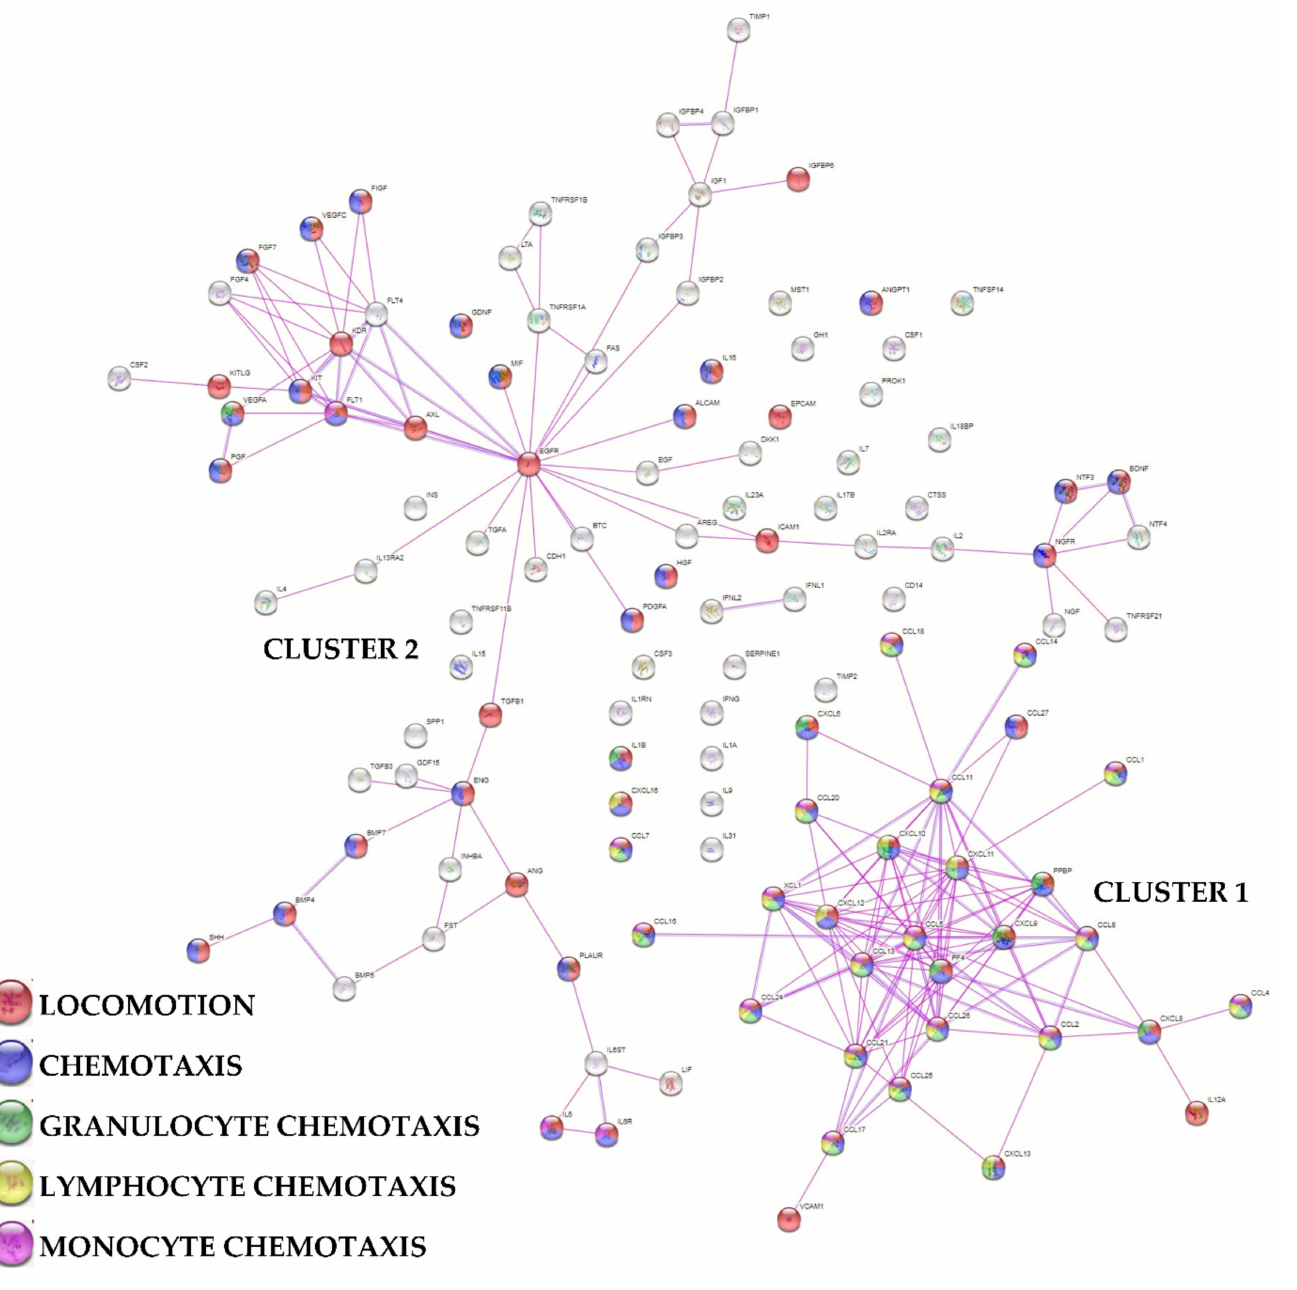
Figure 3. Functional association network for identified secreted factors released by SF-treated BMSCs. Using the online tool STRING, protein-protein interaction levels for 125 proteins of the BMSCs secretome were mined. The blue connections are for proteins with known interactions based on curated databases; violet connections for proteins with experimentally determined interactions. Empty nodes, proteins of unknown 3D structure; filled nodes, known or predicted 3D structure. Locomotion, chemotaxis, granulocyte chemotaxis, lymphocyte chemotaxis and monocyte chemotaxis related factors are